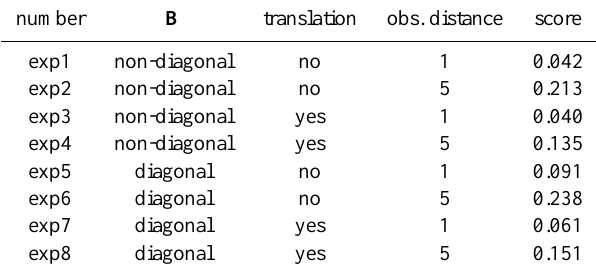
Table 1. Description of the eight assimilation experiments: assump- tion for the B matrix, translation approach (no, T1 or T2), distance (in gridpoints) between the observations that are assimilated, score (r.m.s. of analysis error) of the experiment.